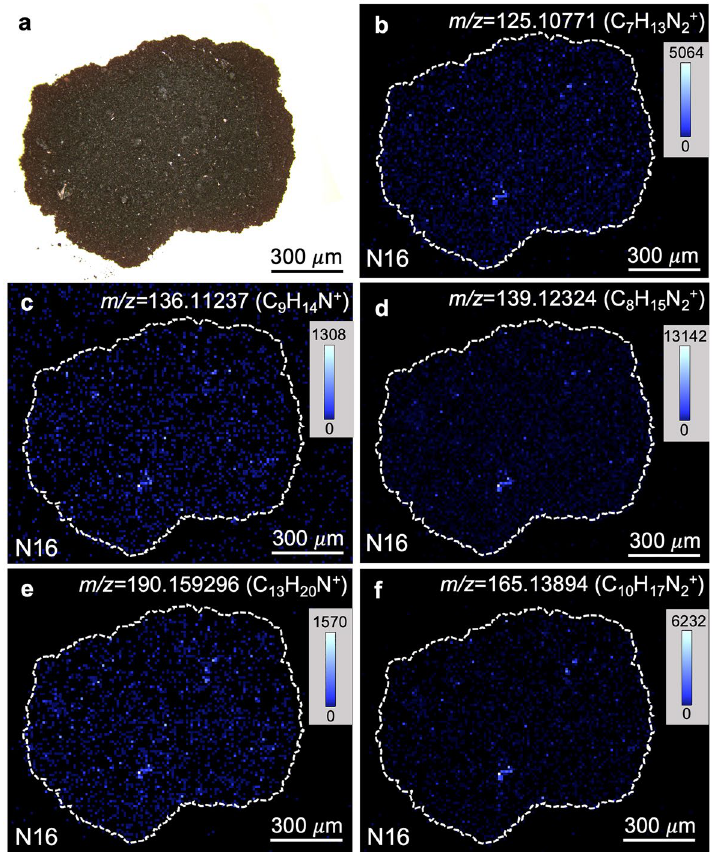
Figure 2. Similarity in the spatial distributions of CNH compounds in NWA 801 meteorite. ( a ) Optical reflection image. ( b ) Mass imaging of m/z = 125.10771 in cluster N16 corresponds to C 7 H 13 N 2 + . ( c ) Mass imaging of m/z = 136.11237 in cluster N16 corresponds to C 9 H 14 N + . ( d ) Mass imaging of m/z = 139.12324 in cluster N16 corresponds to